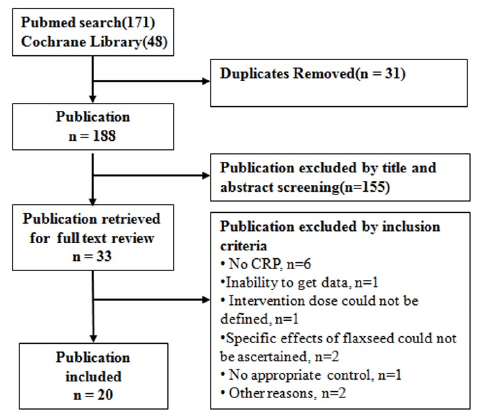
Figure 1. Flow chart of study selection.